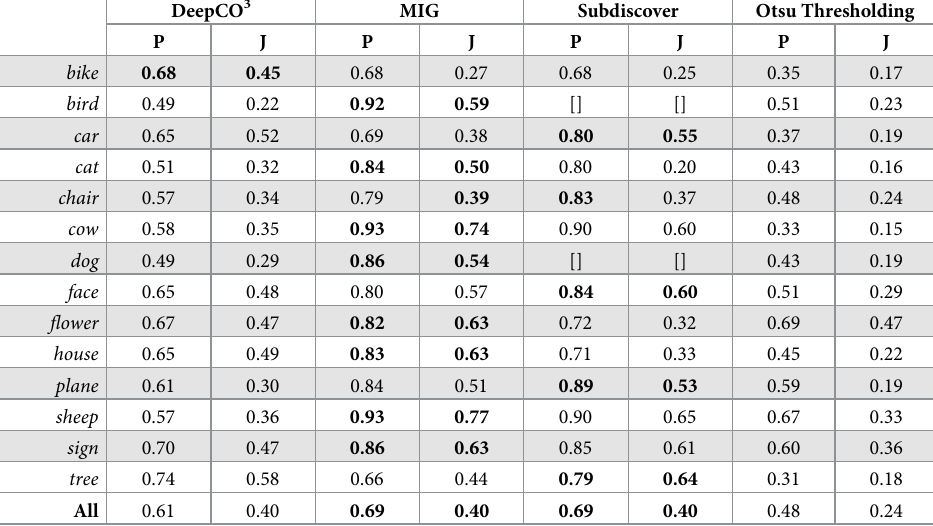
Table 5. Results of three cosegmentation methods and one plant phenotyping segmentation method on the MSRC dataset. DeepCO 3 MIG